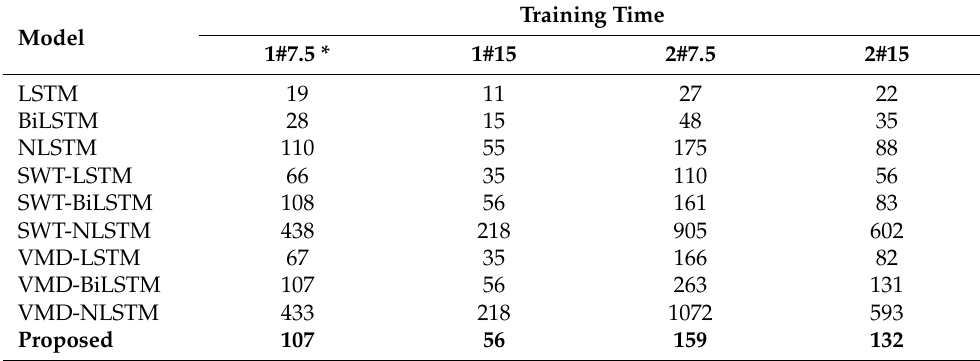
Table 8. Training time in seconds for different forecasting